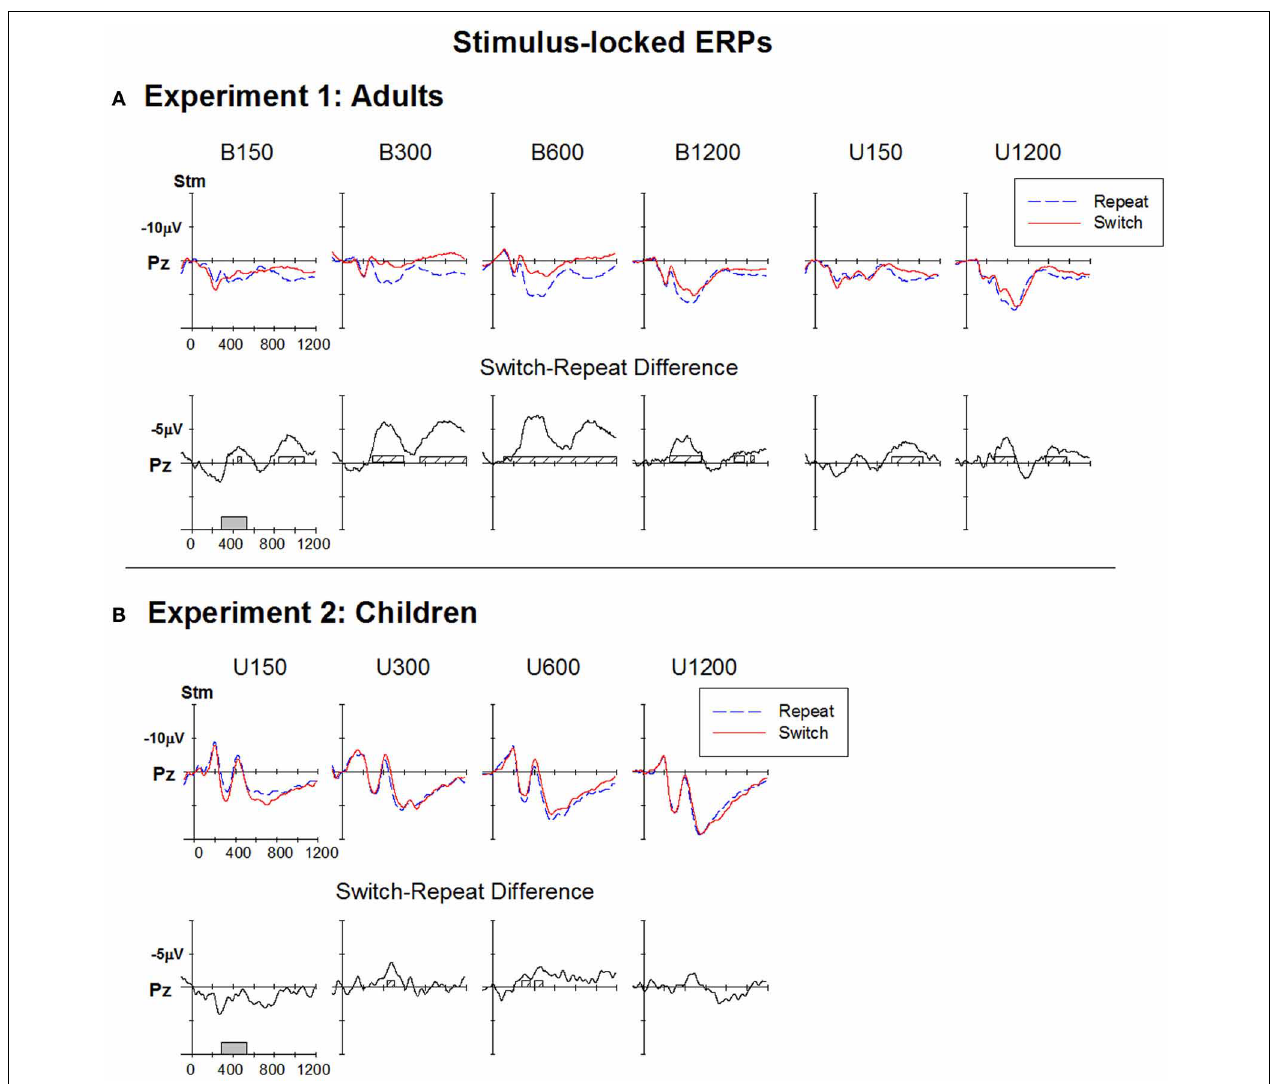
FIGURE 5 | Stimulus-locked ERPs for switch and repeat trials and (switch—repeat) difference waveforms at Pz for (A): Experiment 1 (Adults) and (B): Experiment 2 (Children). Filled gray bars on timeline